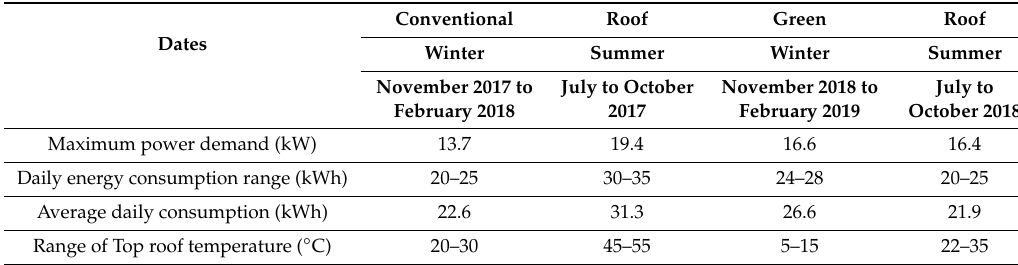
Table 2. Energy demand for conventional and green roof.